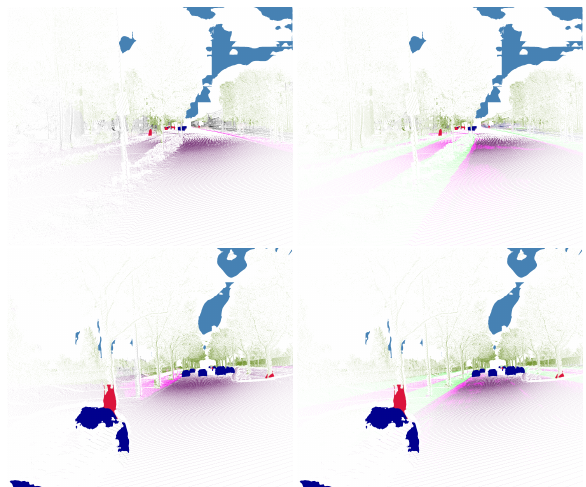
Figure 5. Examples for uncorrected (left) and corrected (right) predictions. (Best viewed